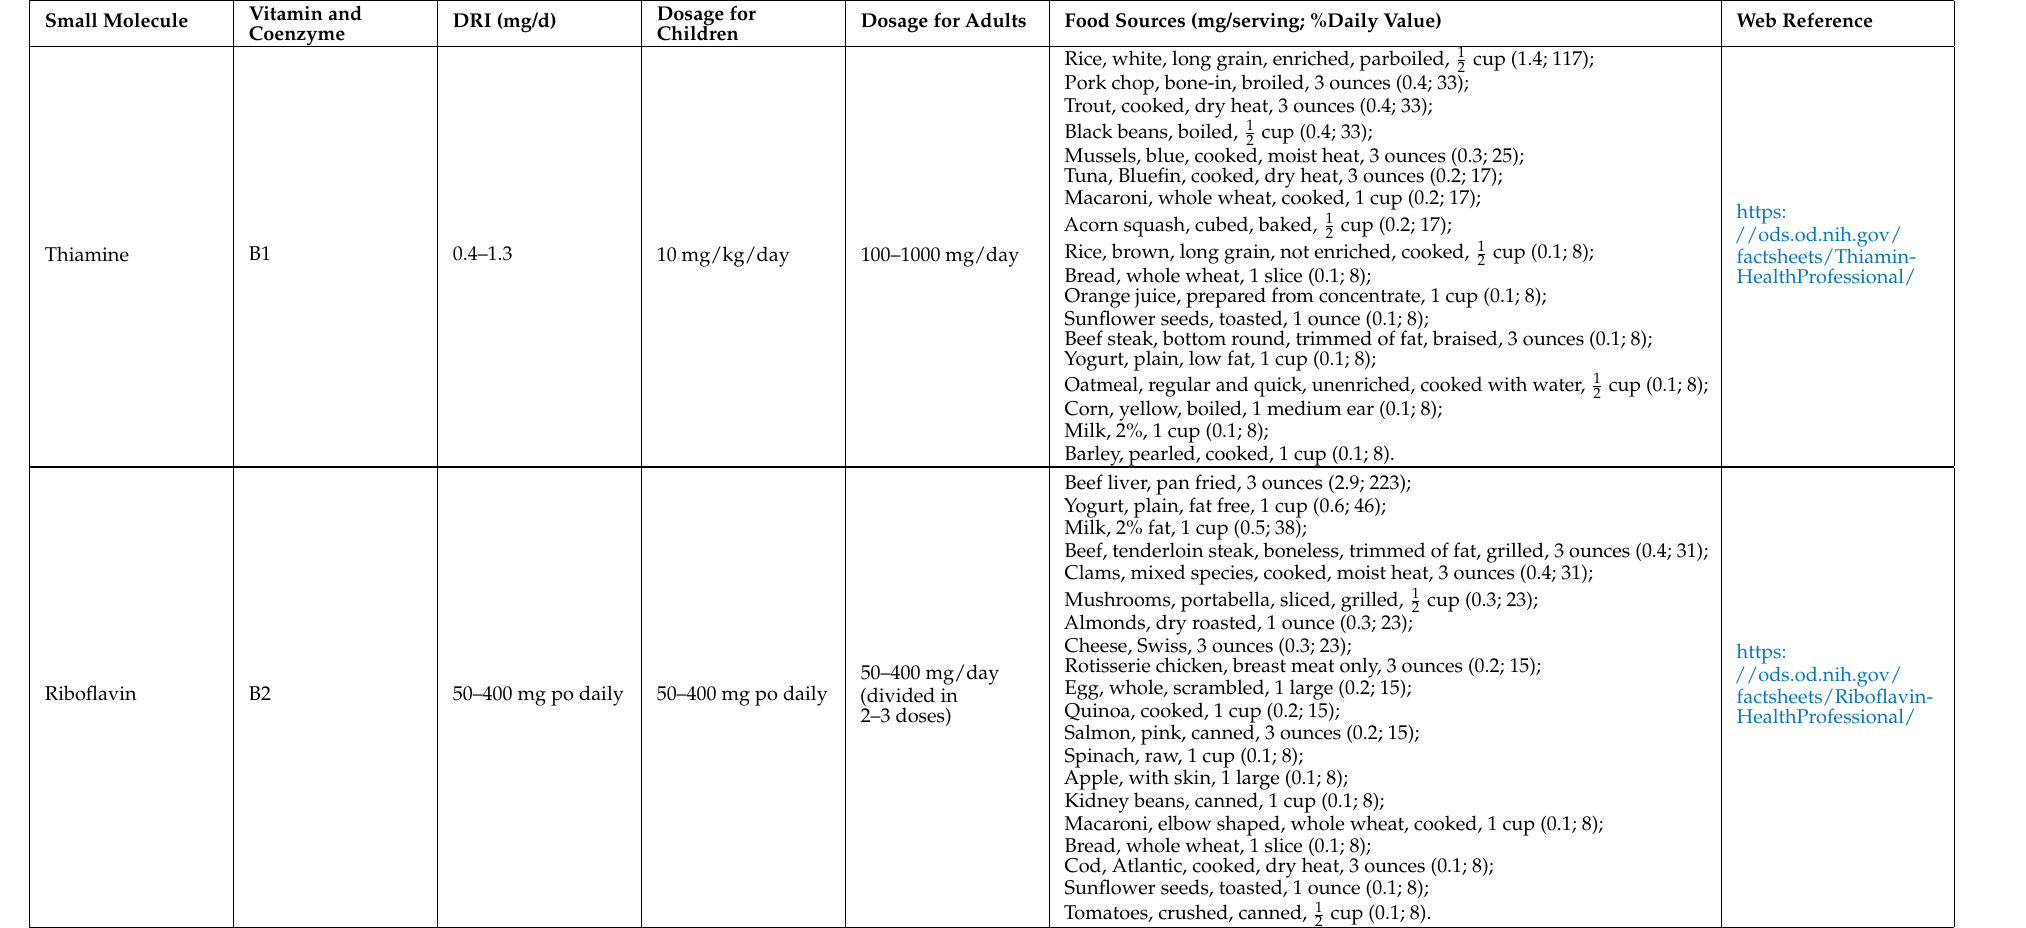
Table 1. Hydrosoluble vitamin DRIs are reported according to https://www.ncbi.nlm.nih.gov/books/NBK222881/ and https://sinu.it/. An estimation of daily nutrient recommendations based on the DRI can be obtained by completing the linked form: https://www.nal.usda.gov/legacy/fnic/dri-calculator/index.php. Dietary supplement dosages for children and adults are coherent with those reported in